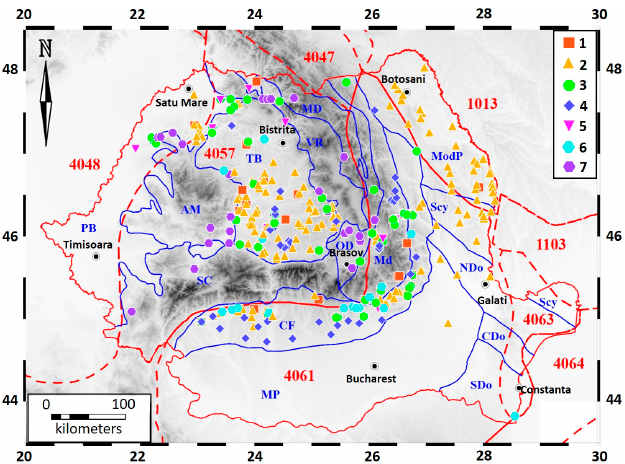
Figure 3. Distribution of the seeps with unknown activity and uncertain seeps in relation to the geologic provinces [47]. 1: gas seep; 2: mud volcano; 3: oil seep; 4: hydrocarbon bearing spring; 5: solid